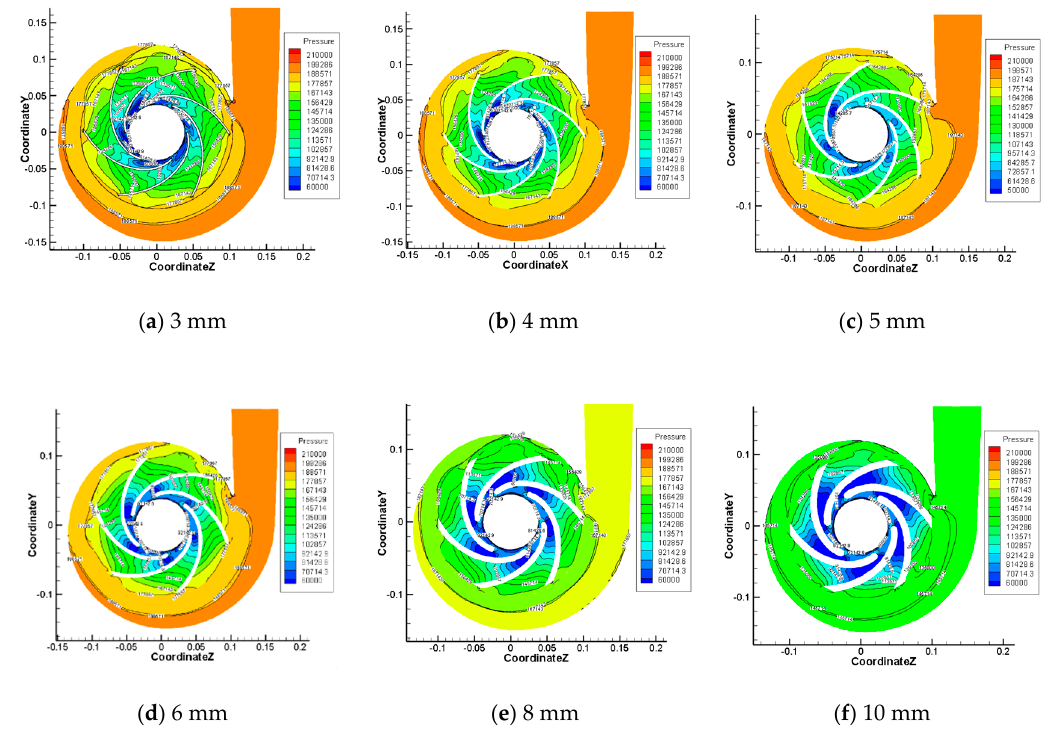
Figure 4. Pressure distribution of CTB.